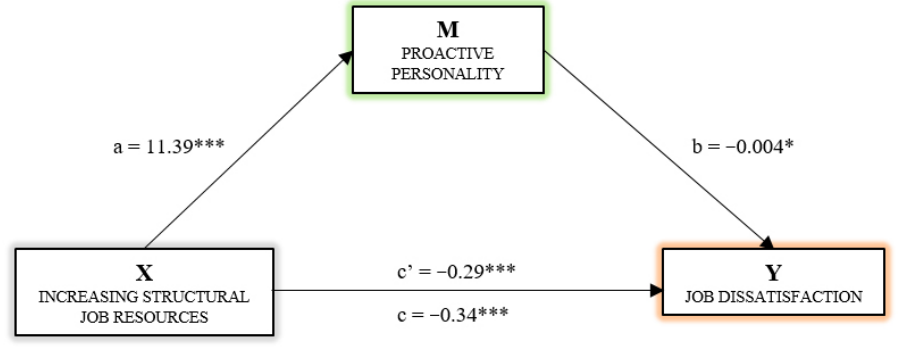
FIGURE 3. Simple mediation model of Proactive personality on the relationship between the IStJR dimension of Job Crafting and Job dissatisfaction of